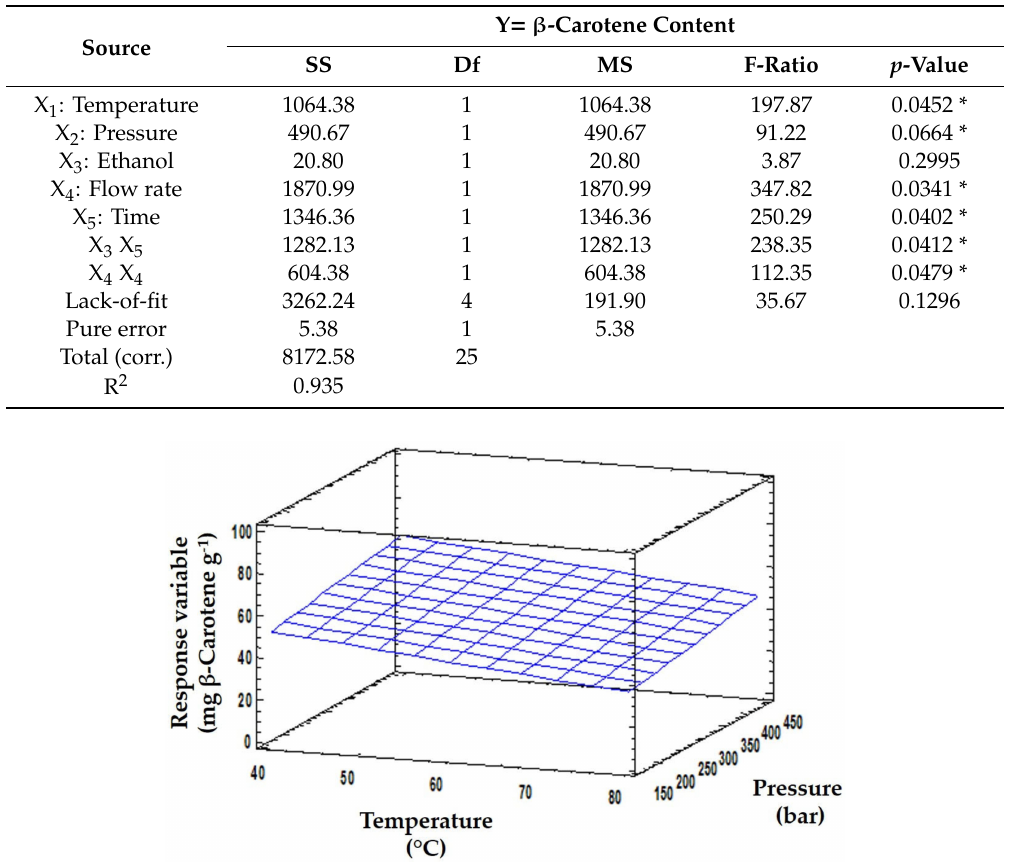
Table 2. Analysis of variance (ANOVA) and fitting parameters of the proposed CCD 2 5 model. square; R 2 = Quadratic correlation coe ffi cient.